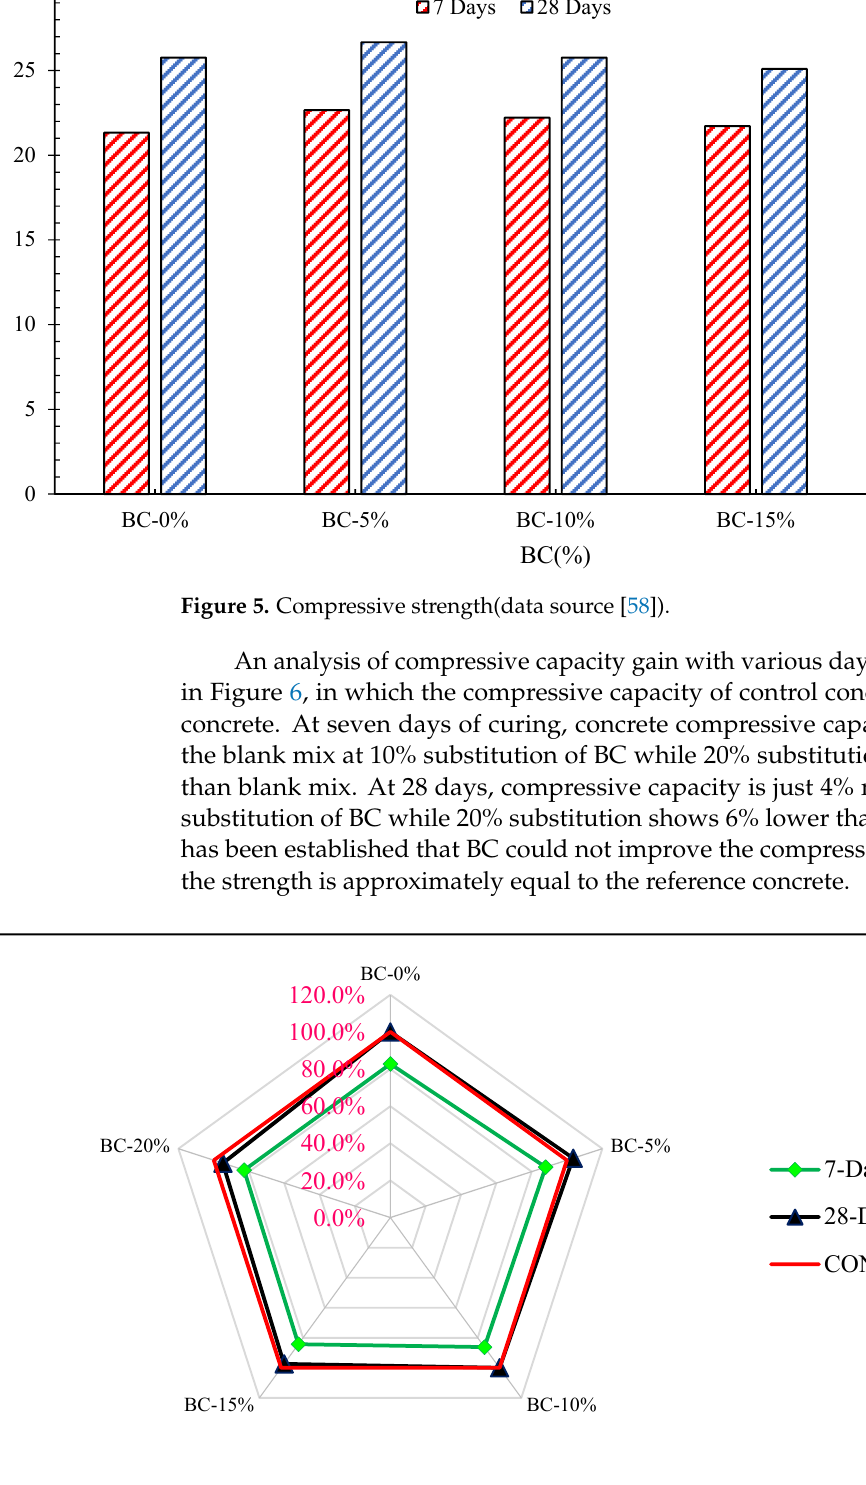
Figure 6. Relative analysis of compressive strength (data source [58]).